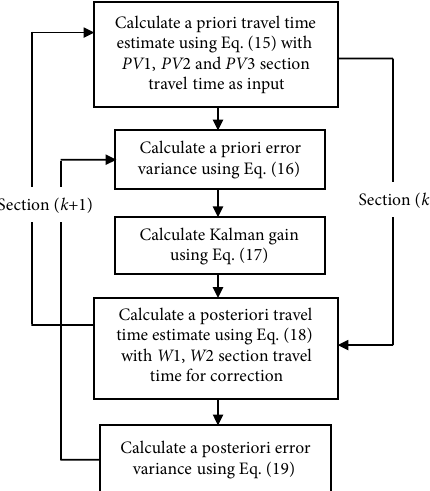
Fig. 2. Flowchart showing the proposed methodology